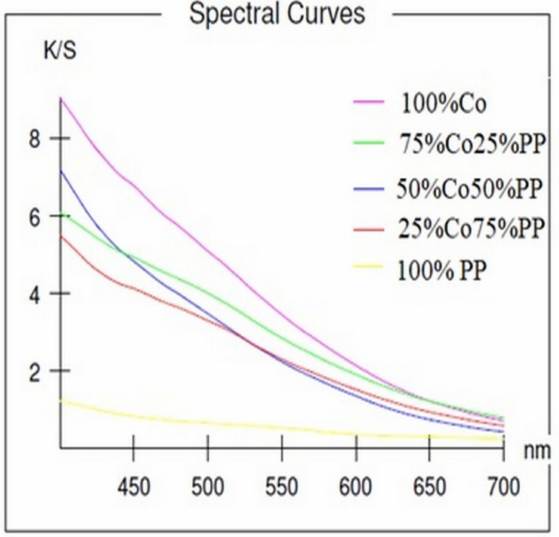
Figure 5. Spectral curves of colour intensity variation of biocomposite materials obtained from polypropylene and coir fibres on the visible